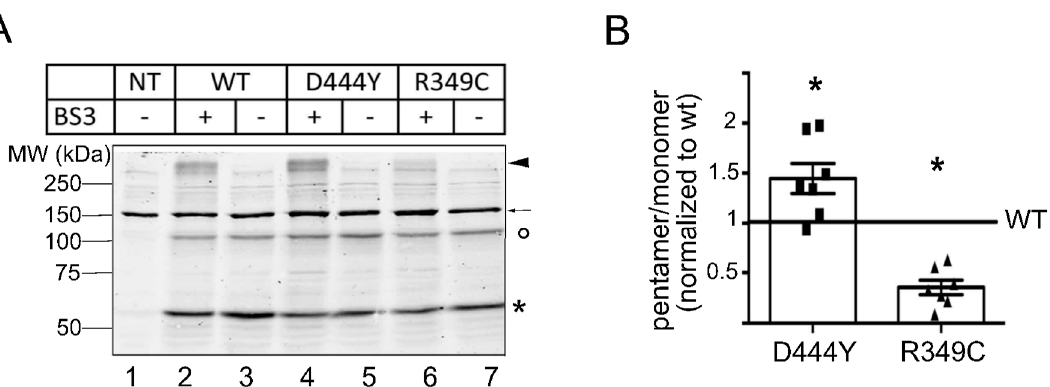
Figure 4. Pentamers containing the D444Y ‐β 4 subunit are enriched in the plasma membrane, but those containing the R349C ‐β 4 subunit are retained intracellularly. ( A ) After 48 h at 32 °C, NRK cells transfected with dimer plus a WT ‐β 4, D444Y ‐β 4 or R349C ‐β 4 subunit were incubated with 2 mM of the impermeable crosslinker BS 3 for 20 min at 32 °C. After quenching the residual BS 3 with glycine, the cells were lysed, and sample extracts were run on SDS ‐ PAGE gels. The membranes were stained with anti ‐β 4 antibody (a representative image of the staining is shown). A band corresponding to the molecular weight of the pentamers ( ≈ 280 kDa, ◀ arrowhead) and indicating the presence of pentameric α 3 β 4 receptors on the cell surface appeared only in the presence of the crosslinker (lanes 2, 4 and 6). The circle( ○ ) and the asterisk (*) mark the dimer and monomer, respectively; the arrow ( ← ) indicates a non ‐ specific band recognised by the anti ‐β 4 antibody that is also recognised in the lysate of non ‐ transfected NRK cells (NT, lane 1). ( B ) Graph of the quantification of seven independent experiments showing the percentage of pentamers in comparison to the WT. The presence of the D444Y ‐β 4 ( ◼ ) subunit significantly increased the number of α 3 β 4 nAChRs on the cell surface (* p = 0.031) whereas the presence of the R349C ‐β 4 ( ▲ ) significantly decreased the number of α 3 β 4 nAChRs (* p = 0.015) (ANOVA, Wilcoxon test).